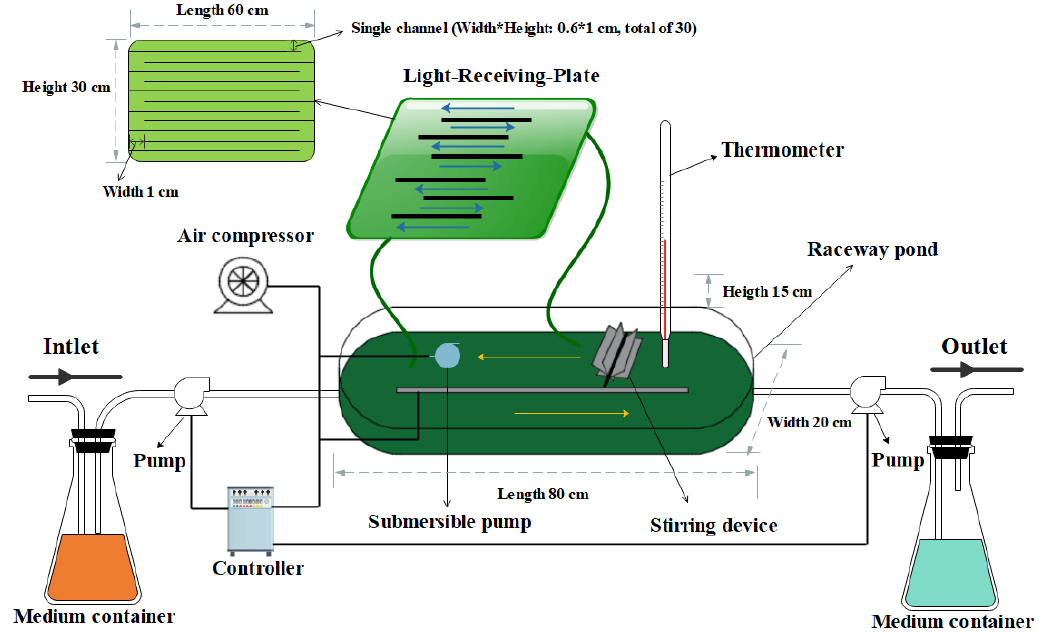
Figure 1. Schematic diagram of the light-receiving-plate (LRP)-enhanced raceway pond. 141